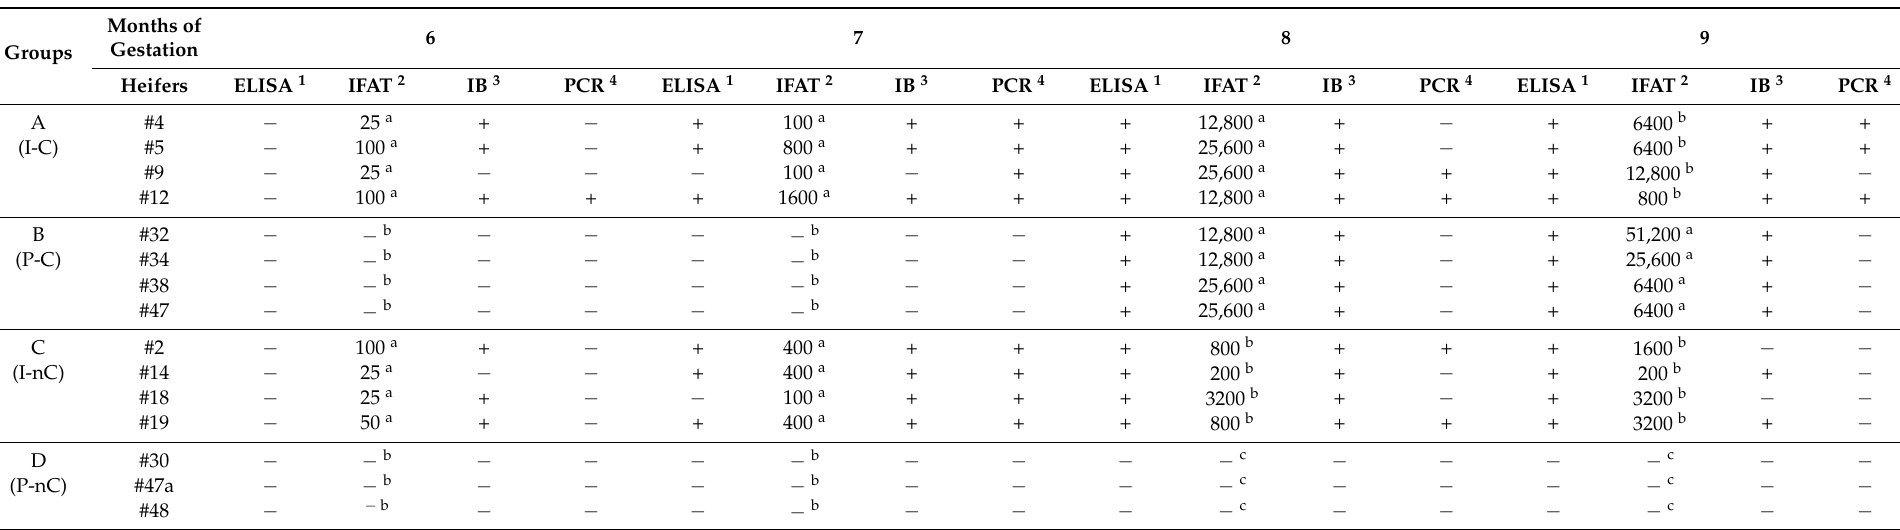
Table 2. Reactivation study in inoculated heifers in the last 4 months of gestation. I-C: inoculated and challenged; P-C: placebo and challenged; I-nC: inoculated not challenged; P-nC: placebo not challenged. PBMCs: peripheral blood mononuclear cells. IB: immunoblot. 1 Cut-off 1:100; 2 Cut-off 1:25; 3 Cut-off 1:100; 4 From PBMC. + and − indicate a positive and negative result, respectively, for each of the assays. Lowercase letters (a and b) indicate significant differences between different